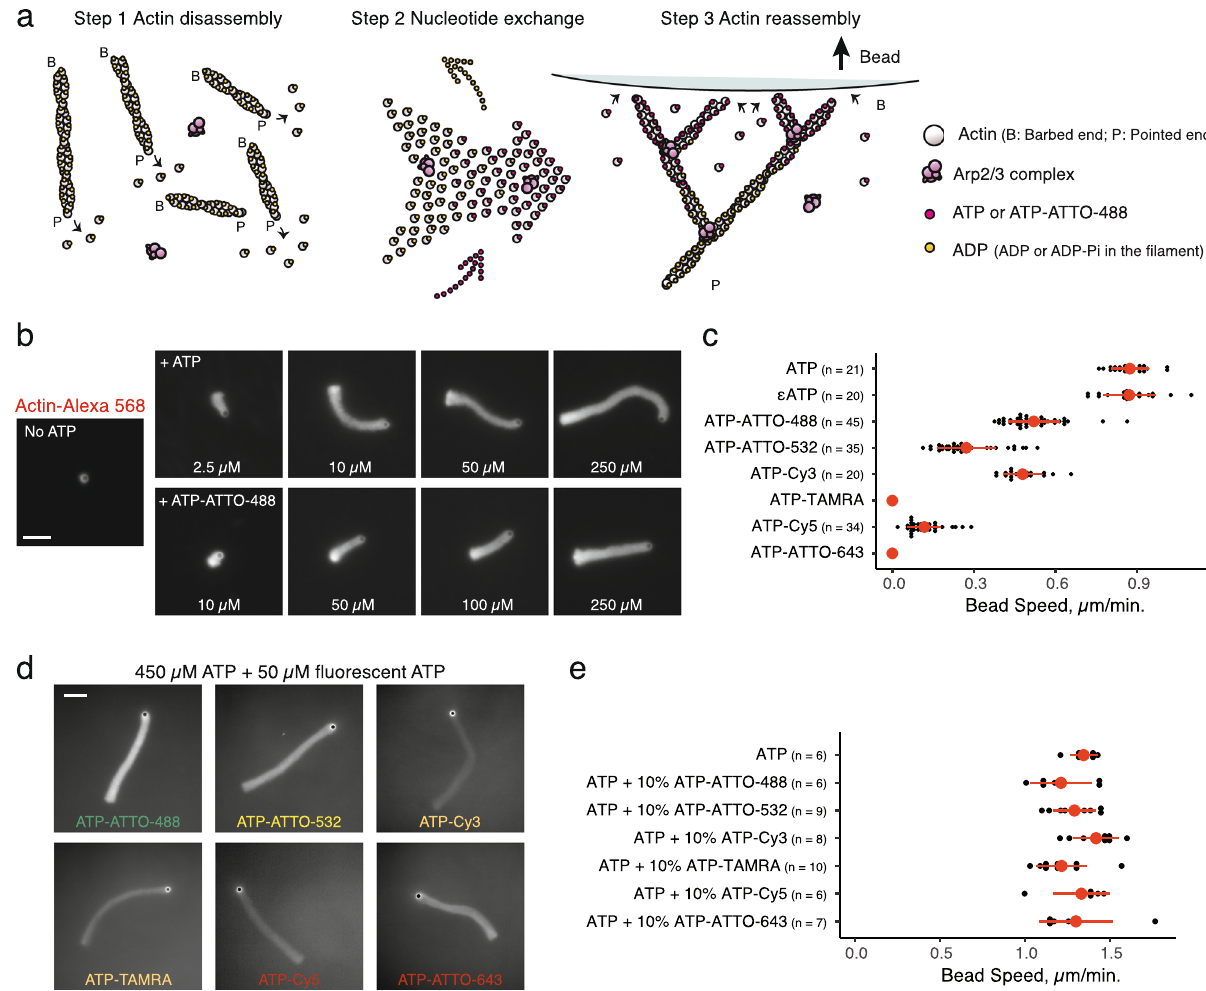
Fig. 5 Design of a biomimetic assay to evaluate the potency of fl uorescent ATPs as energy sources for actin-based force generation. ATP adenosine triphosphate, Arp actin-related protein, TAMRA tetramethylrhodamine. Scale bars: 10 µ m. a Rational design of experiments performed from pre-assembled unlabeled actin fi laments to investigate the functionality of fl uorescent ATPs in an actin-based motility assay. Fluorescent ATPs are added in solution so that they can replace ADP from disassembling actin monomers, fuel the bead motility assay, and integrate within branched actin networks. b Fluorescence snapshots of branched-actin comets propelling 2- µ m diameter WASp-coated microbeads in the presence of F-actin (1% Alexa-568-labeled for imaging), Arp2/3 complex, pro fi lin, ADF/co fi lin, capping protein, and variable concentration of unlabeled ATP (upper images) or ATP-ATTO-488 (lower images), 30 min after initiation of the experiment, showing that ATP-ATTO-488 can fuel a bead motility assay. Red letters are to clarify that the fl uorescence signal of Actin-Alexa-568 is recorded in this experiment. This experiment was repeated independently three times. c Bead velocity in assays performed in the presence of N 6 -(6-Amino)hexyl-ATP fl uorescent derivatives (50 µ M) conjugated to a selection of fl uorophores, showing that not all fl uorescent ATPs are valid energy sources. Red dots indicate average values and red bars standard deviations. d Fluorescence snapshots of branched-actin comets in the presence of ATP (450 µ M) and fl uorescent ATP (50 µ M), 30 min after initiation of the experiment. Colored letters are to clarify that the fl uorescence signal of ATP derivatives are recorded in this experiment. This experiment was repeated independently three times. e Beads velocity in the presence of ATP (450 µ M) and fl uorescent ATP (50 µ M), showing that although not all fl uorescent ATPs are functional, they can still be used as markers of actin network assembly. Red dots indicate average values and red bars standard deviations. Source data are provided as a Source Data fi